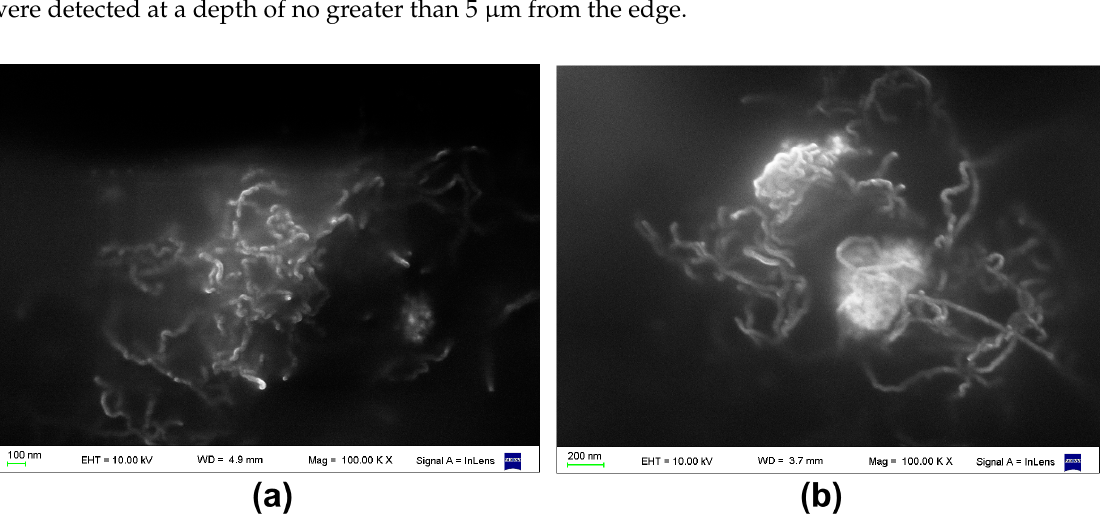
Figure 3. SEM images: ( a ) PDMS/MWCNT (MWCNT: 1% w/w ). ( b ) PDMS/MWCNT/CoFe 2 O 4 (MWCNT: 1% w/w ; CoFe 2 O 4 : 2% w/w ). The bright areas correspond to signals originating from the heaviest elements associated to CoFe 2 O 4 agglomerates.